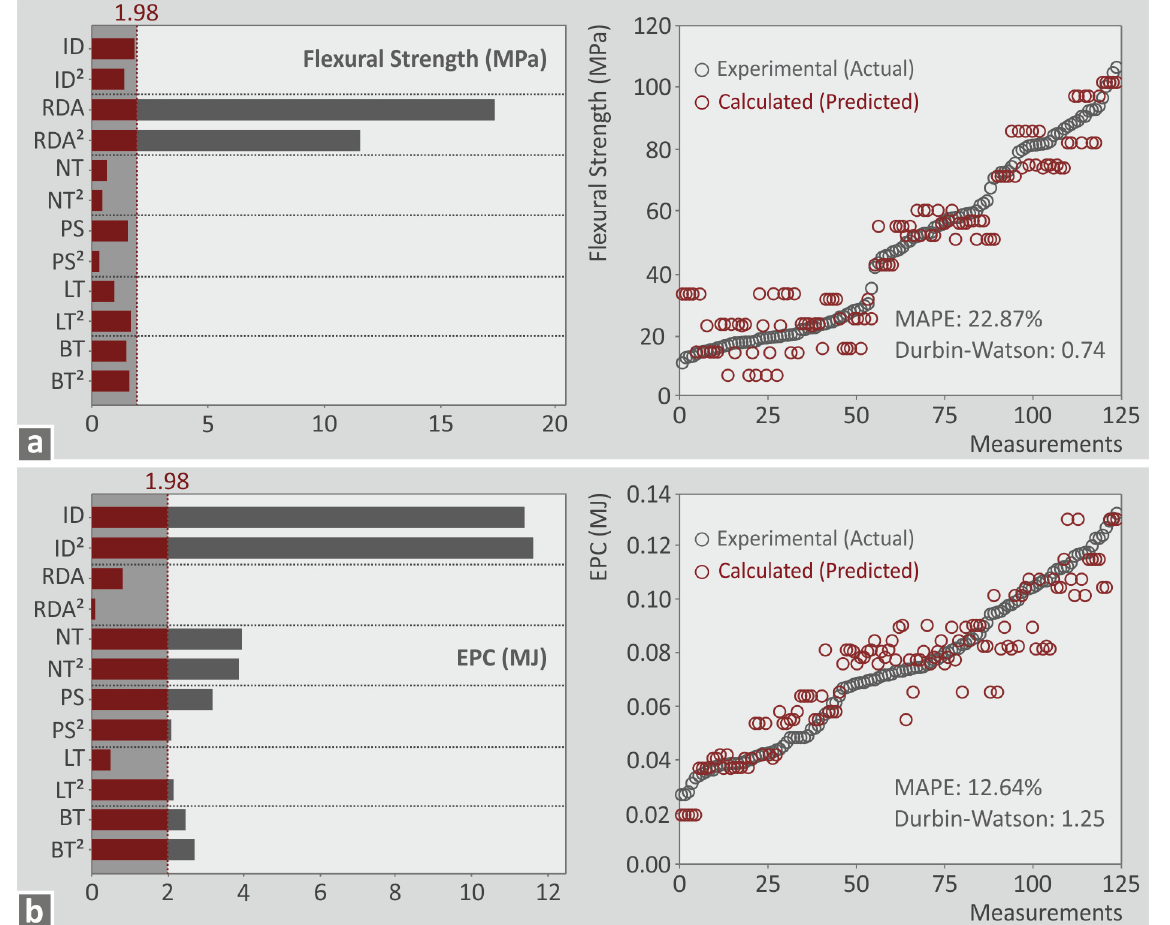
Figure 11. Pareto diagram along with a graph depicting a comparison between the experimental and the calculated values of the following metrics: ( a ) flexural strength (MPa), ( b ) EPC (MJ). The effect of two (high-ranked) combined control parameters for each metric is pre- sented in the following Figure 12 in a three-dimensional surface graph. Four metrics are depicted, i.e., printing time (s), part weight (g), flexural strength (MPa), and EPC (MJ). PS and LT were the control parameters ranked as no.1 and no.2 for the printing time. Figure 12a shows the printing time vs. these two control parameters. Figure 12b shows the sB metric vs. PS and ID control parameters (rank no.3 and no.4, respectively). Figure 12c shows the EPC control metric vs. PS and BT (rank no.3 and no.4, respectively). Figure 12d shows the part weight vs. the ID and the PS which were also ranked as no.1 and no.2 control parameters for the specific metric. Figure 12e shows the sB metric vs. RDA and NT control parameters (rank no.1 and no.2, respectively). Finally, Figure 12f shows the EPC control metric vs. LT and ID (rank no.1 and no.2,